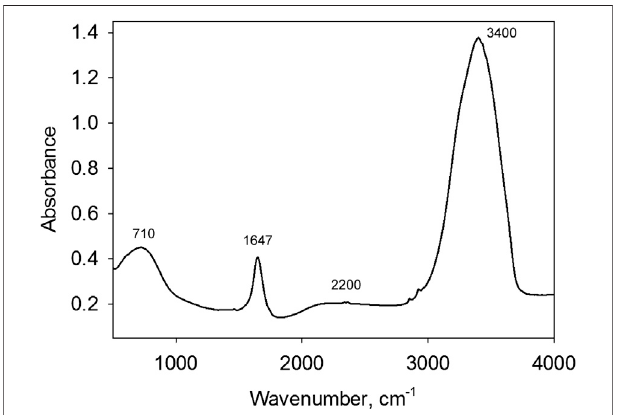
FIGURE 7 | The emission spectra of the 1 mg/ml IFN γ solution and buffer solutions at 25 ° S .